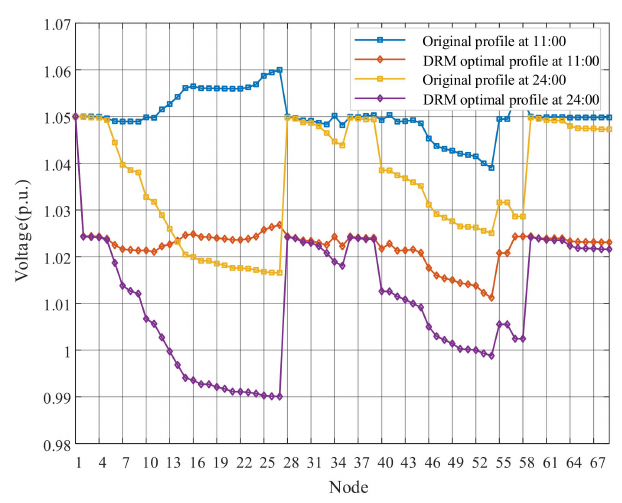
Figure 6. The nodal voltages of 11:00 and 24:00.